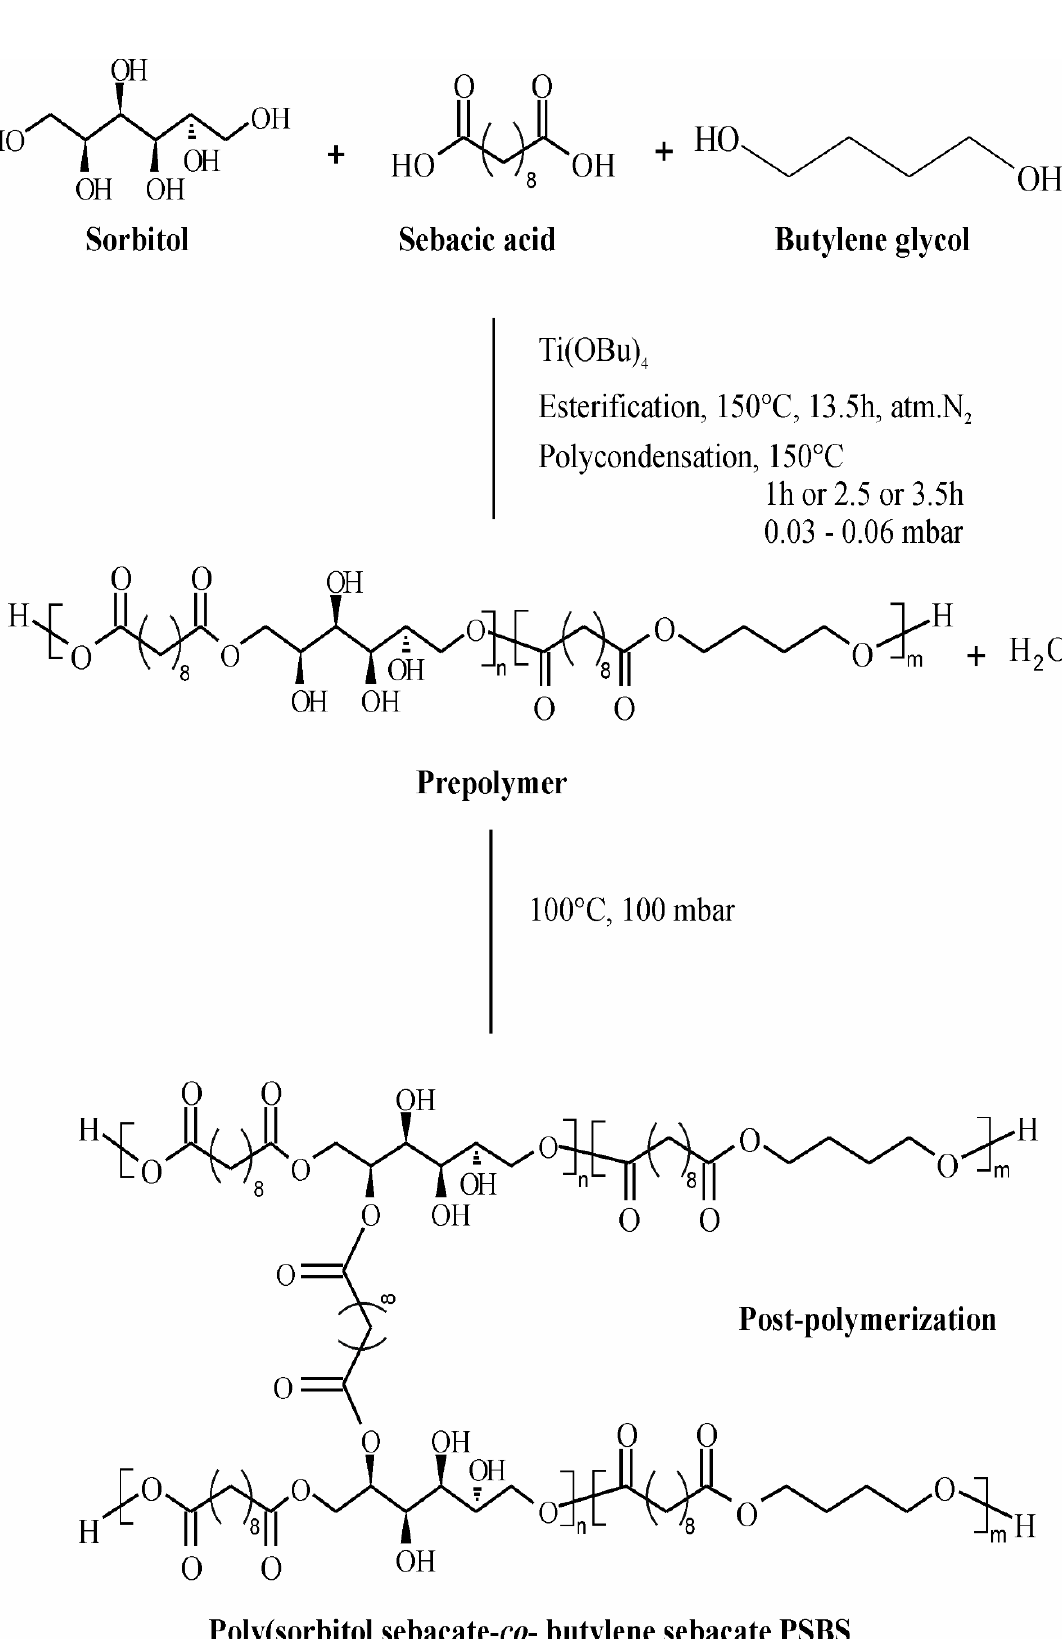
Figure 1. Scheme of poly(sorbitol sebacate-co-butylene sebacate) (PSBS) synthesis .